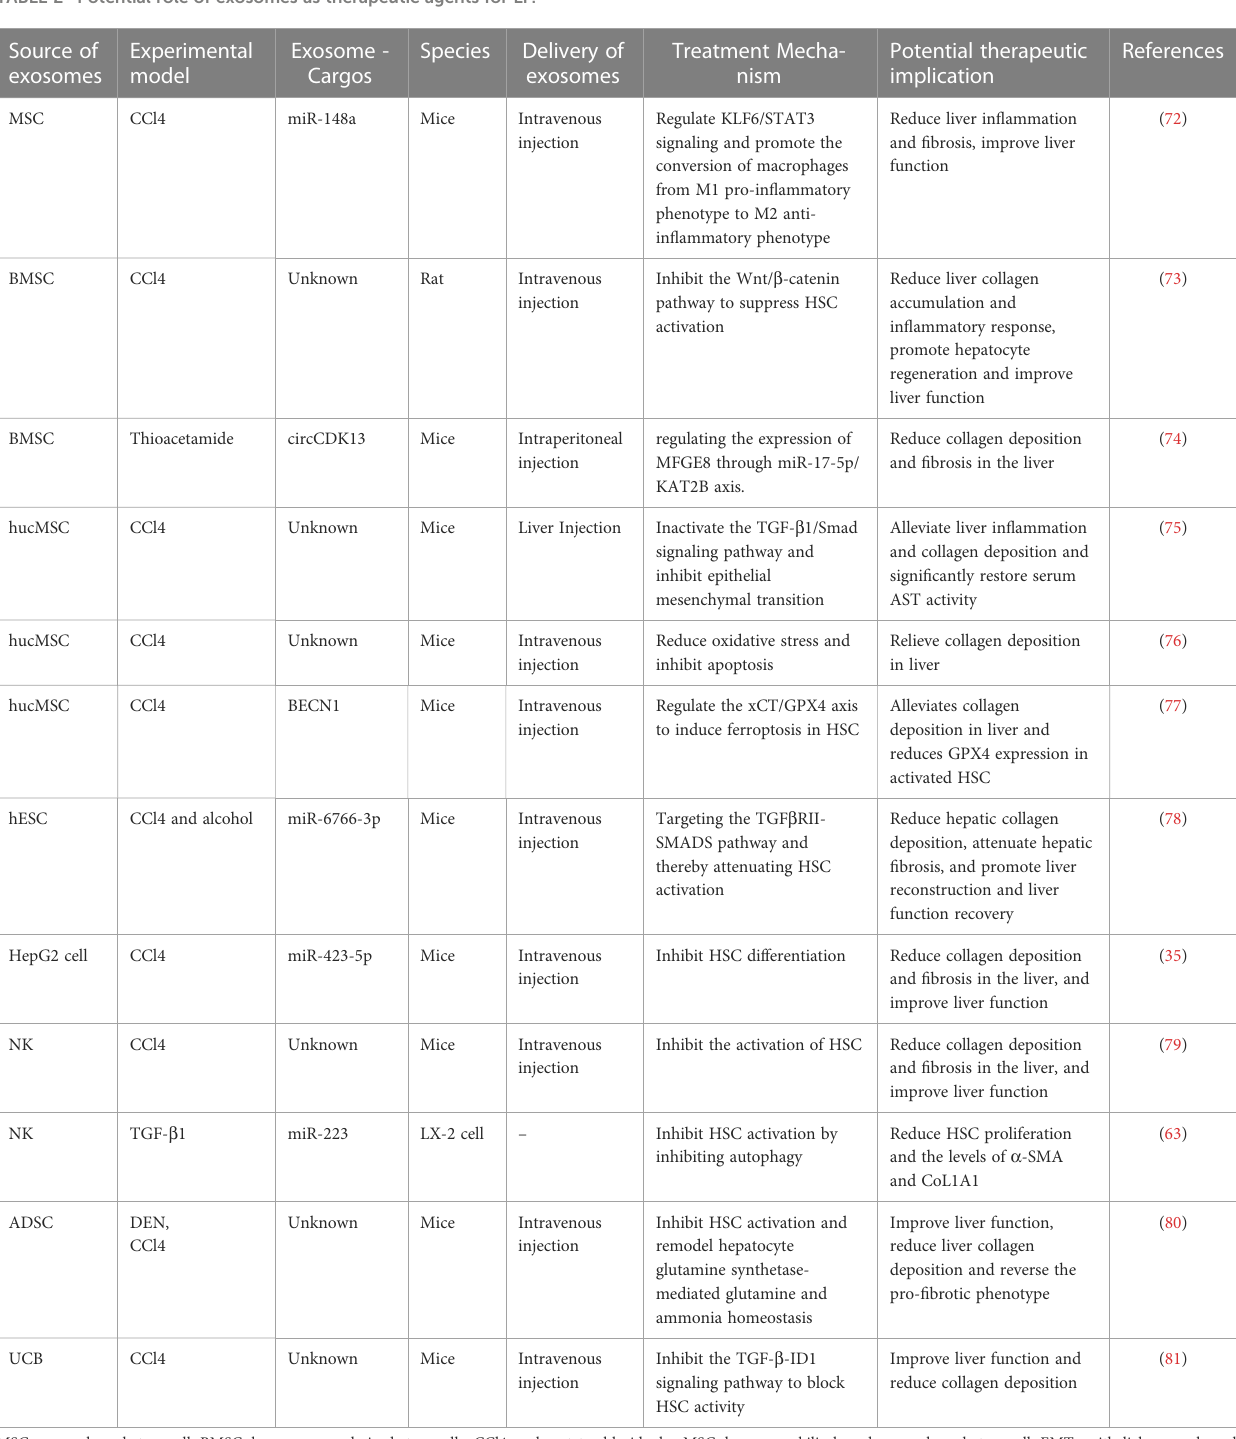
TABLE 2 Potential role of exosomes as therapeutic agents for